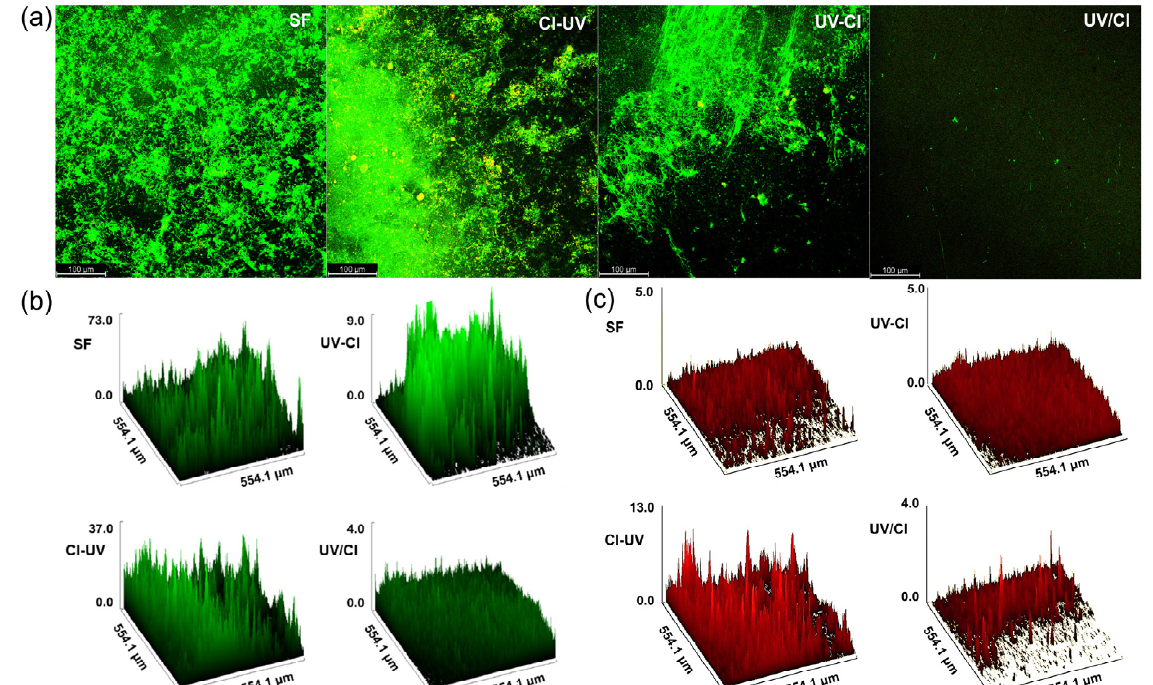
Figure 6. CLSM micrograph of biofilm grown in waters from SF, UV-Cl, Cl-UV and UV/Cl. Projected upper view of the biofilm ( a ); Estimated total bacteria intensity of surface plot of the biofilm ( b ); Estimated dead bacteria intensity of surface plot of the biofilm ( c ).